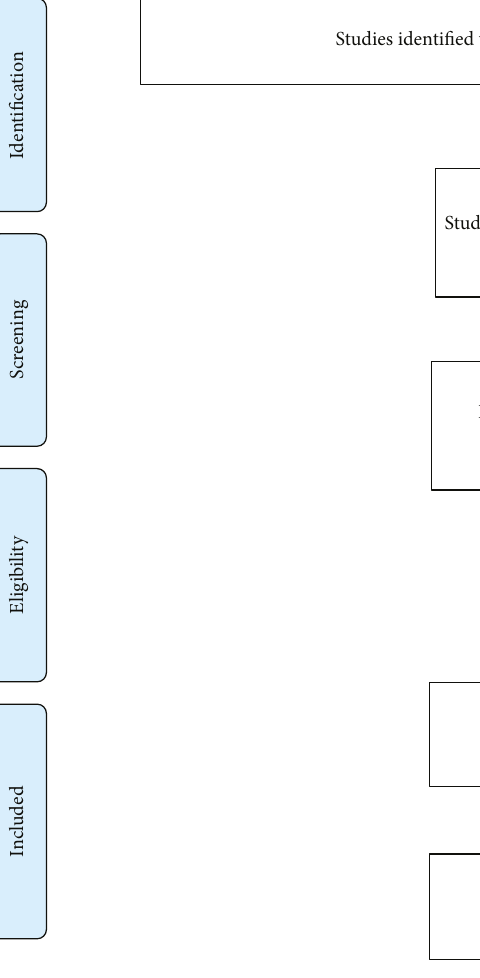
Figure 1: Study fl